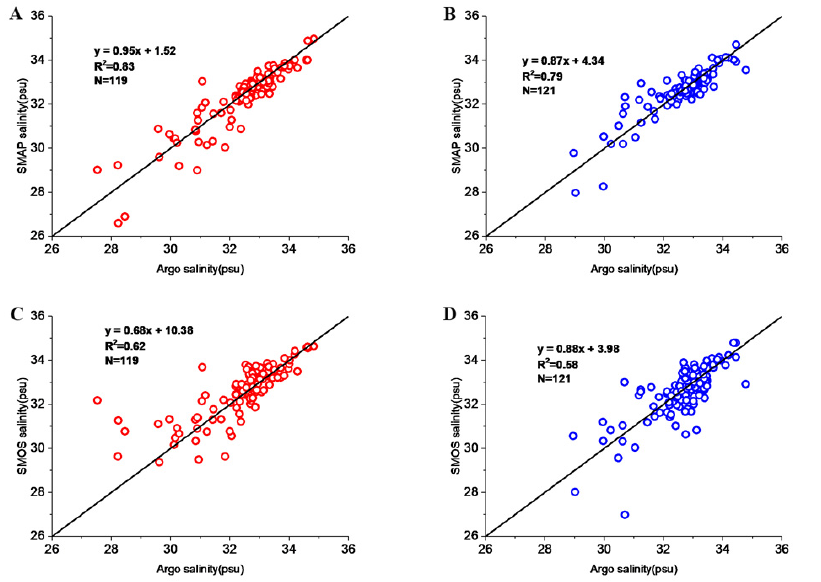
Figure 2. Scatter map of Soil Moisture Active Passive Salinity (S SMAP ), Soil Moisture and Ocean Salinity (SMOS), and Argo salinity (S Argo ) data. ( A , B ) Correlation between S SMAP and S Argo before and after TCs, respectively; ( C , D ) correlation between S SOMS and S Argo before and after TCs, respectively. (Note: red dots represent the matched pairs before 10 TCs and blue dots represent the matched pairs after 10 TCs). Each dot represents collocated matched pairs and black lines show a 1:1 relationship. The linear correlation coefficients are significantly different from zero at 95% confidence ( p -value).